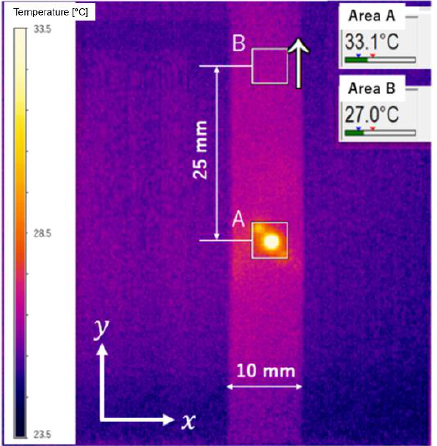
Figure 3. Thermograph of a test specimen during local heating.